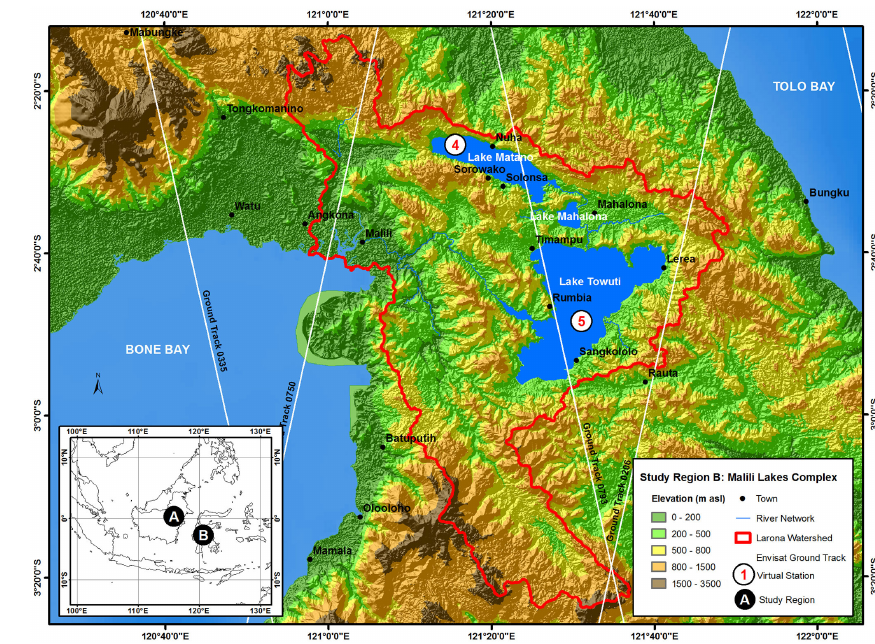
Figure 2. Study sites at the Malili lake complex, South Sulawesi,